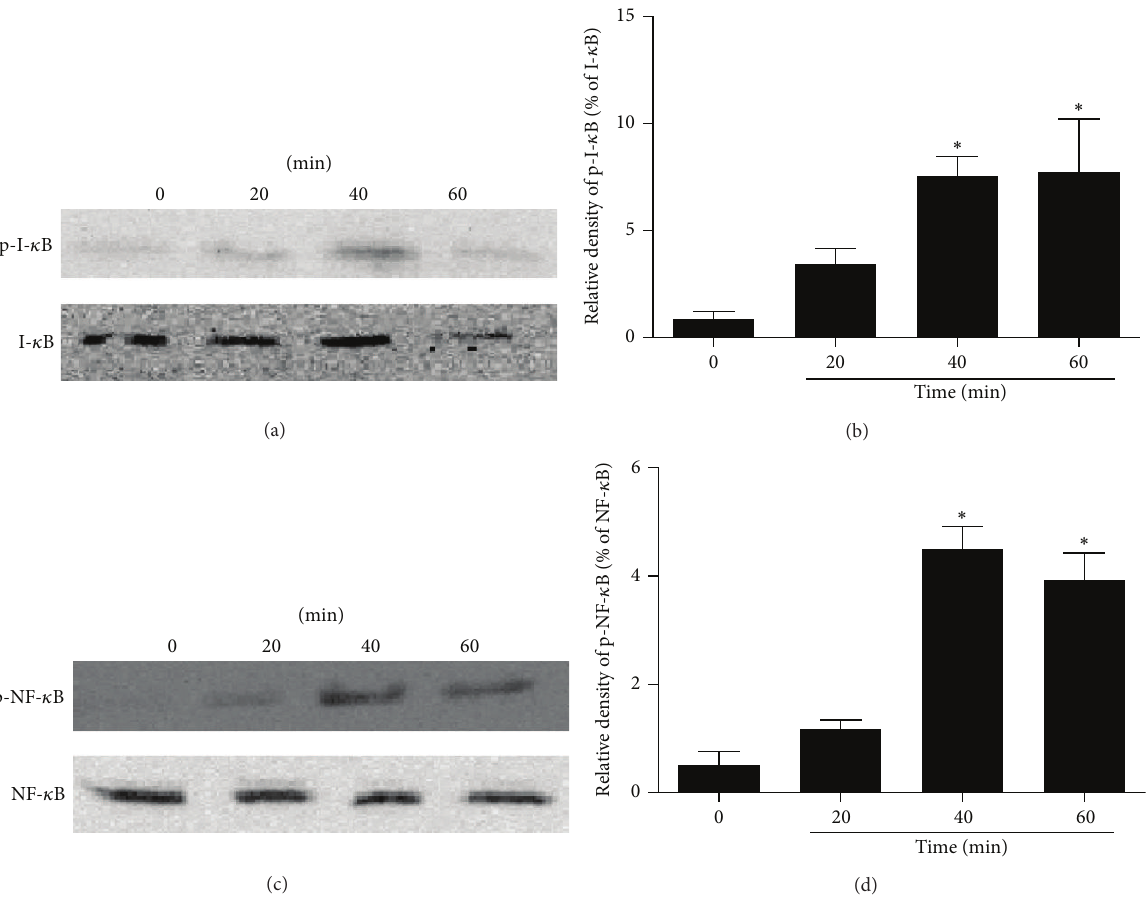
Figure 4: Time courses of recombinant Bla g 7 (rBla g 7) induced I- 𝜅 B and NF- 𝜅 B activation in dendritic cells (DCs). (a, c) rBla g 7 at 1 𝜇 g/mL was incubated with DCs at 37 ∘ C for 0, 20, 40, and 60 min, respectively. Protein levels were detected by immunoblot analysis with specific antibodies. Western blots at the top of each panel are from a typical experiment. (b, d) Bar graphs are the quantified results expressed as mean ± SEM of I- 𝜅 B, p-I- 𝜅 B, NF- 𝜅 B, and p-NF- 𝜅 B levels from three independent experiments. ∗ 𝑃 < 0.05 versus 0 min.